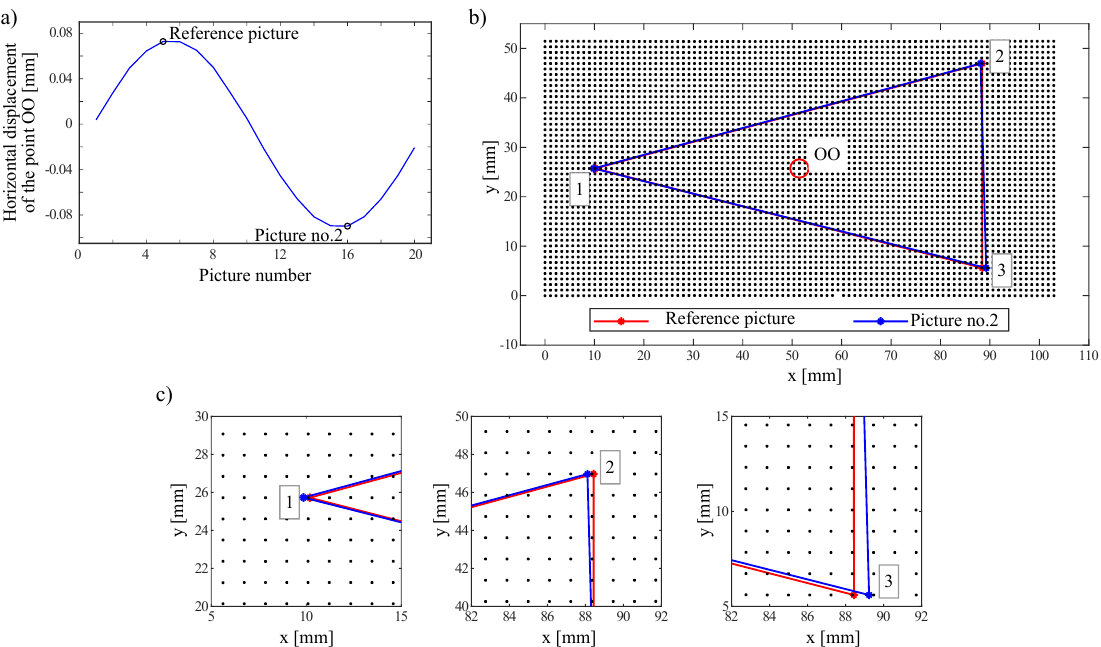
Figure 3. ( a ) Horizontal displacement of point OO (middle point in the observed area, shown in Figure 2e) in one selected set of 20 consecutive pictures, ( b ) the selected triangular area in two opposite states, called the reference picture and Picture No. 2, and ( c ) changes in its